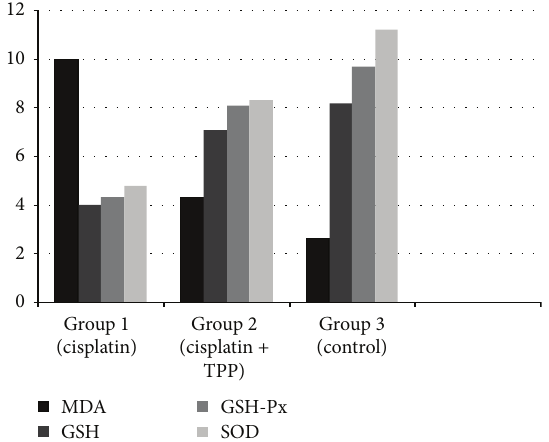
Figure 4: Showing comparison of mean levels between all